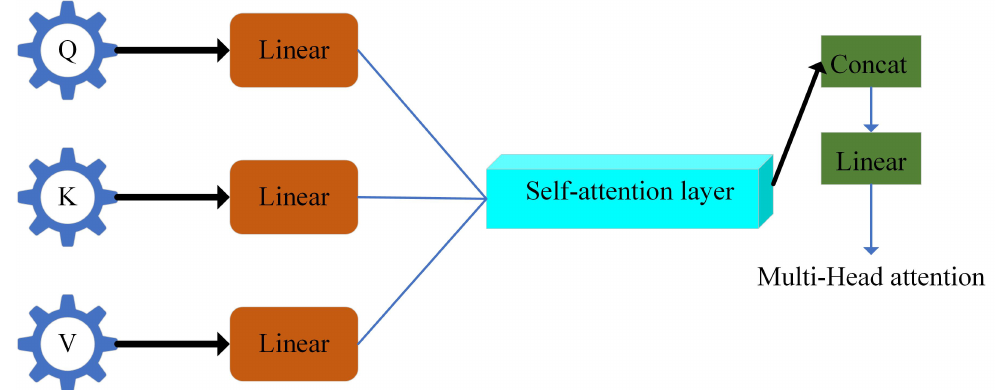
Figure 3. Data processing of multi-head attention